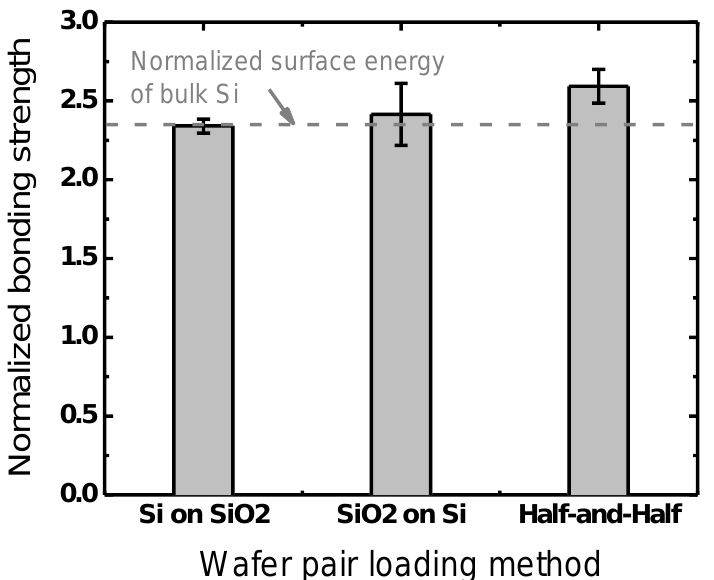
Figure 14. Bonding strengths obtained from different wafer pair loading methods normalized to the bonding strength with no plasma treatment.